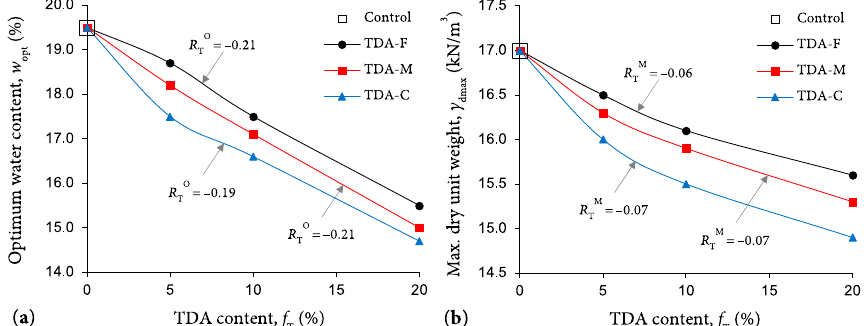
Figure 2. Variations of ( a ) optimum water content w opt and ( b ) maximum dry unit weight γ dmax against TDA content f T for the tested mix designs. against TDA content f T for the tested mix